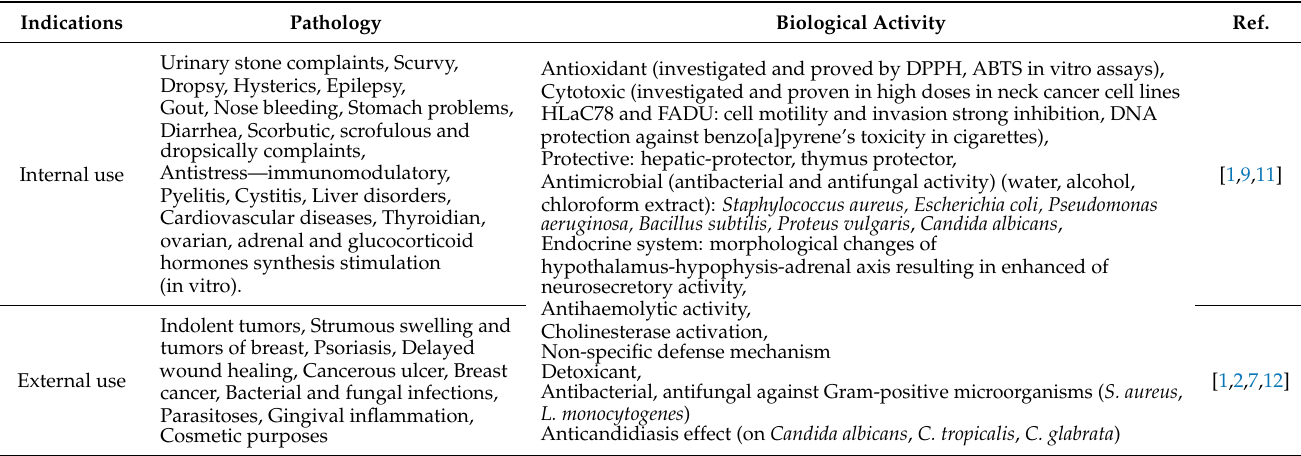
Table 1. Biological activity of Galium verum